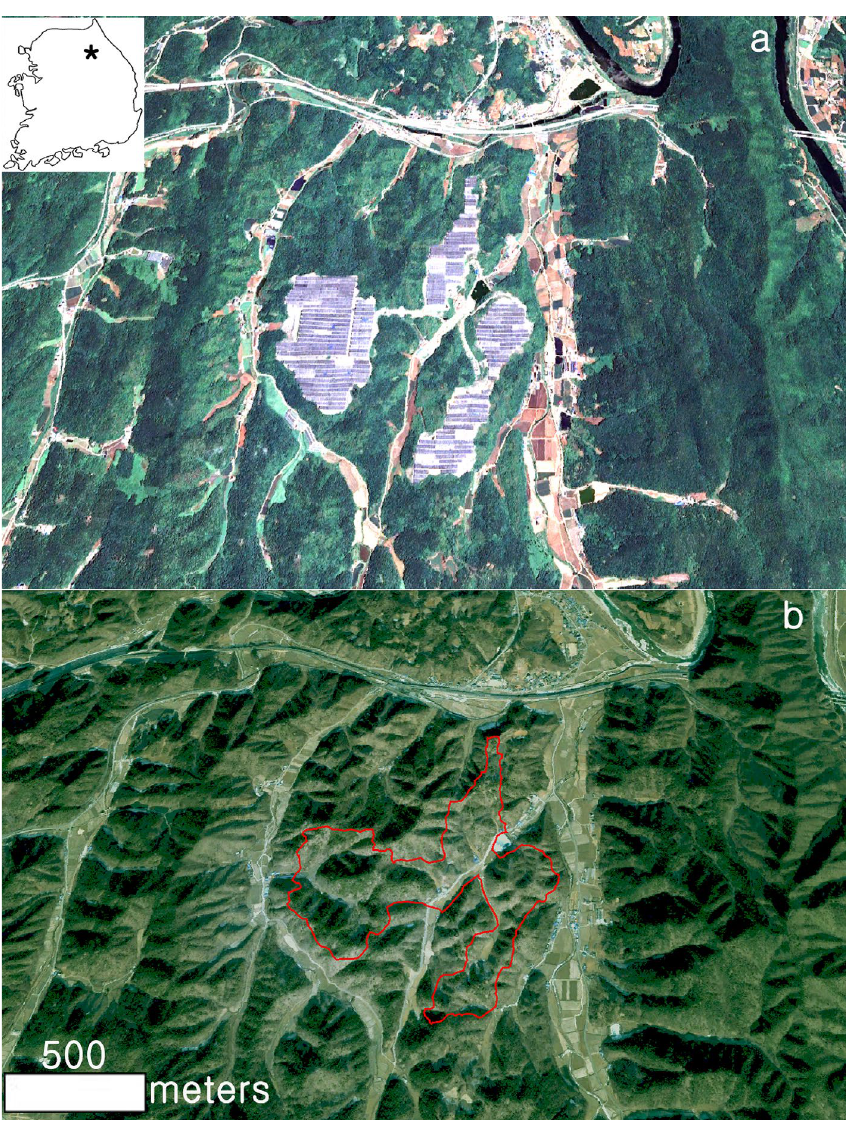
Figure 2. The study area (Youngwol solar power plant in Youngwol-gun, South Korea), ( a ) non-forestry landscape after flat fixed solar panel construction (Pléiades satellite imagery taken in July 2020). Inset: * represents the location of the study site in South Korea. ( b ) forestry landscape before the flat fixed solar panel (QuickBird satellite imagery taken in January 2005). The reddish polygon represents the coverage of solar plants in the upper figure ( a ). 3D magnified portion of the reddish polygon is displayed in Fig. 3, while 2D is presented in Fig. 5. Time series images (2005 and 2020) were obtained from Google Earth Pro 7.3.4 (https:// www. google. com/ earth/ versi ons/# earth- pro). The map created in Google Earth Pro 7.3.4 and Adobe Photoshop CS3 (https:// adobe- photo shop- cs3- update. en. softo nic.